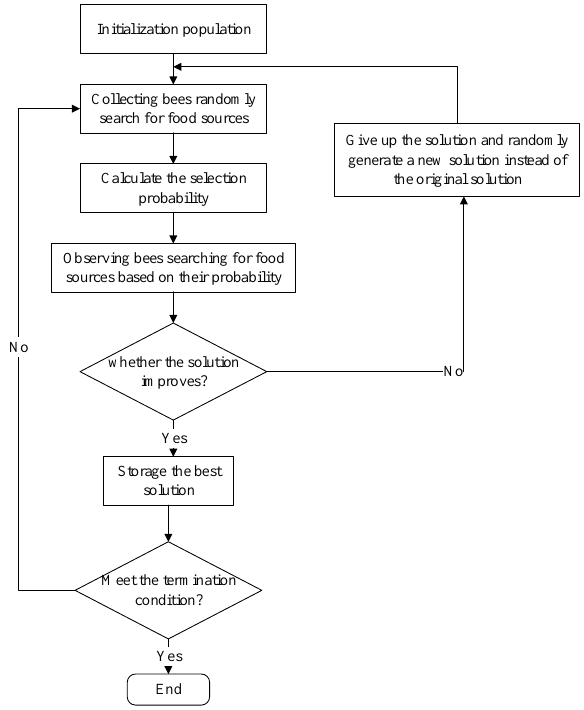
Figure 2. Principle of the artificial bee colony algorithm.